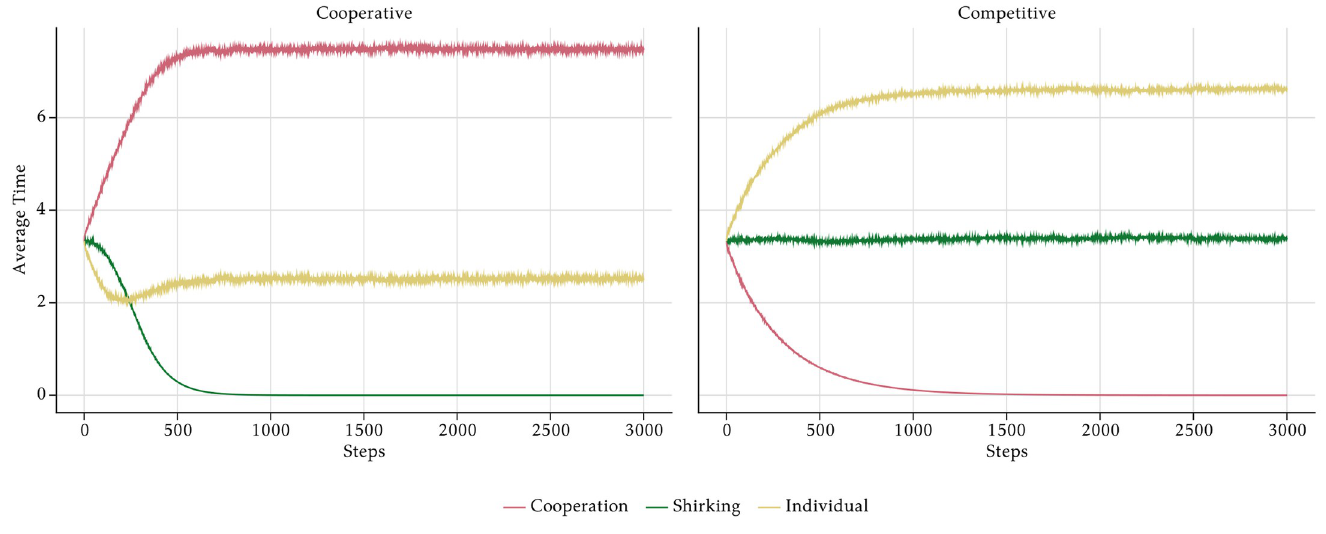
Fig 14. Aggregate average time—No monitoring.